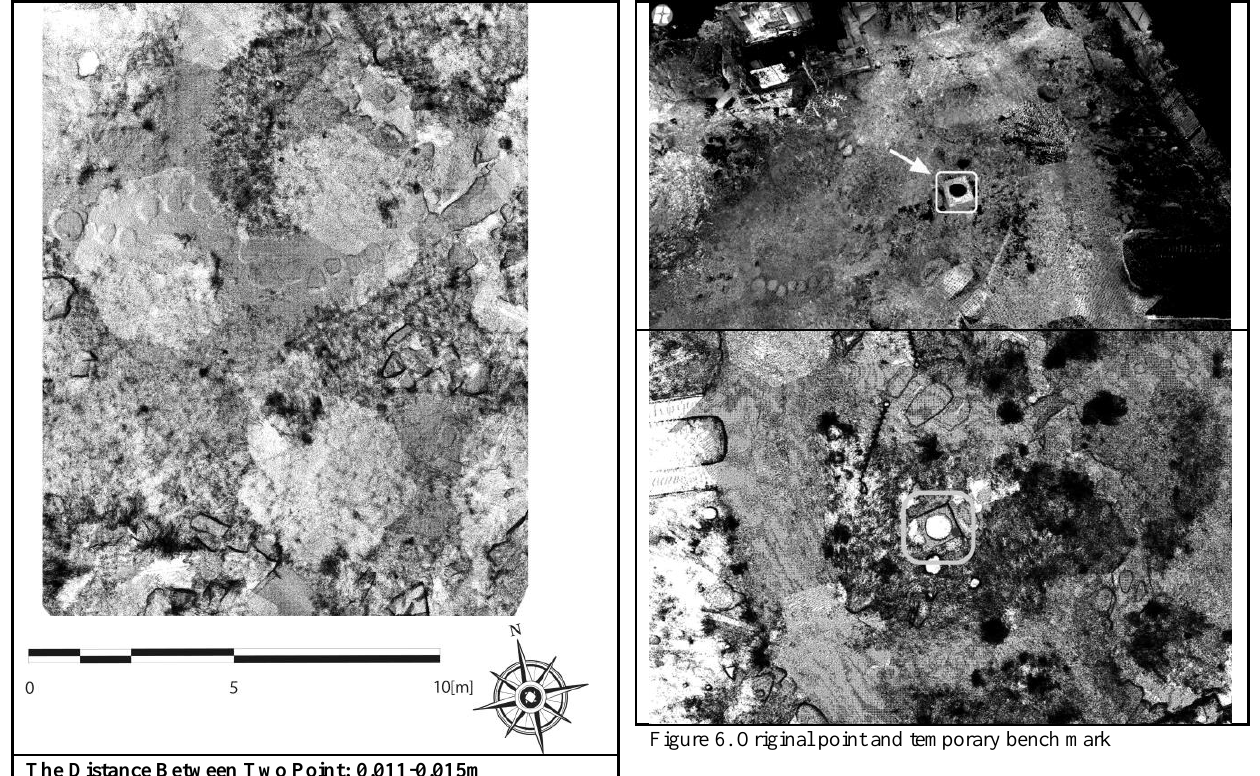
Figure 5. Ground plan of the high point density